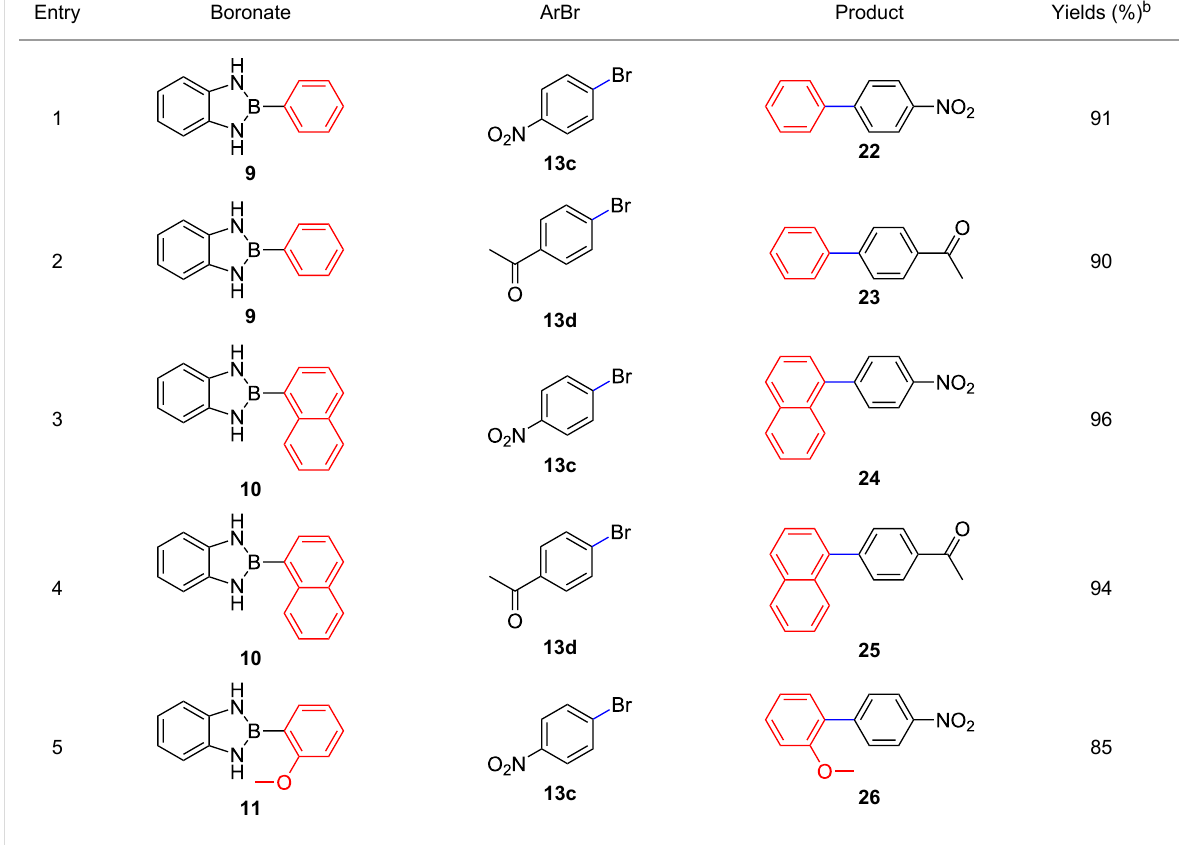
Table 3: Palladium-catalysed cross-coupling of boronate 9 – 12 with 4-bromonitrobenzene, 4-bromoacetophenone and 9-bromoantracene. a Entry Boronate ArBr Product Yields (%)